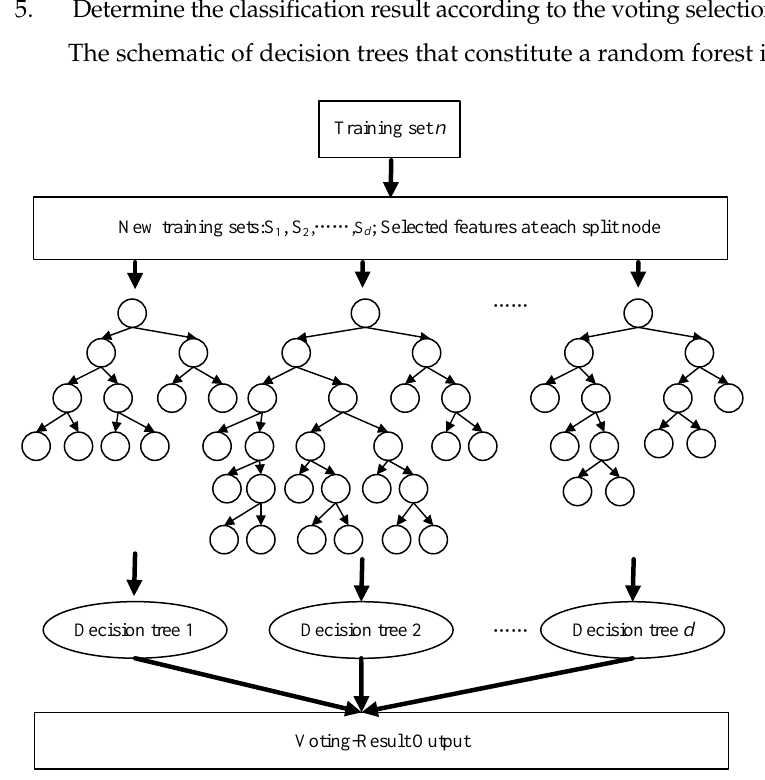
Figure 4. Schematic diagram of one random forest.